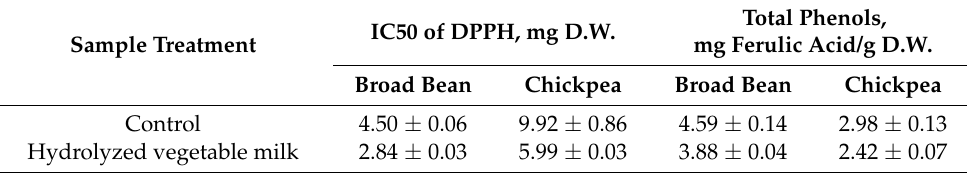
Table 2. Effect of enzymatic hydrolysis on antioxidant activity of vegetable milk obtained from